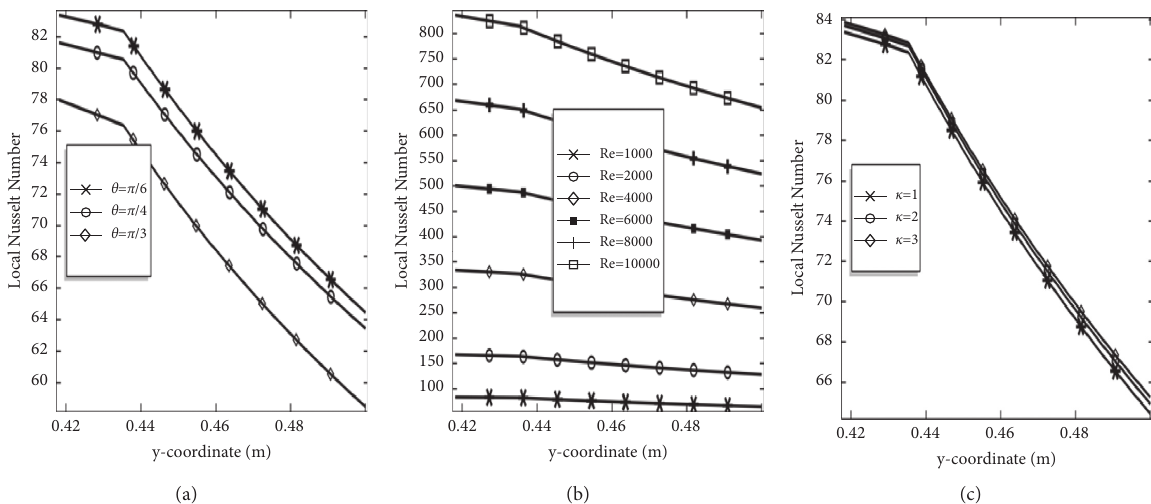
Figure 8: Evaluation of the local Nusselt number ( m/sec ) in the front surface of the circular cylinder (a) for all angles by fixing Re � 1000 and κ � 1; (b) for all Re by fixing κ � 1 and θ � π /6; (c) for all κ by Re � 1000 and θ � π /6.